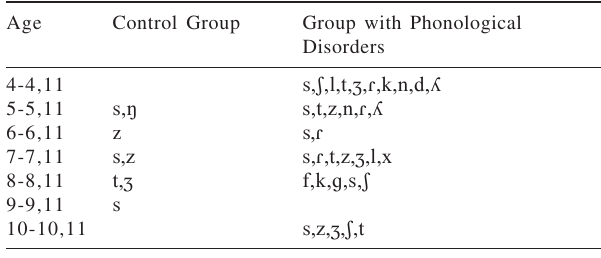
Table 4 - Distorted phonemes by age group.